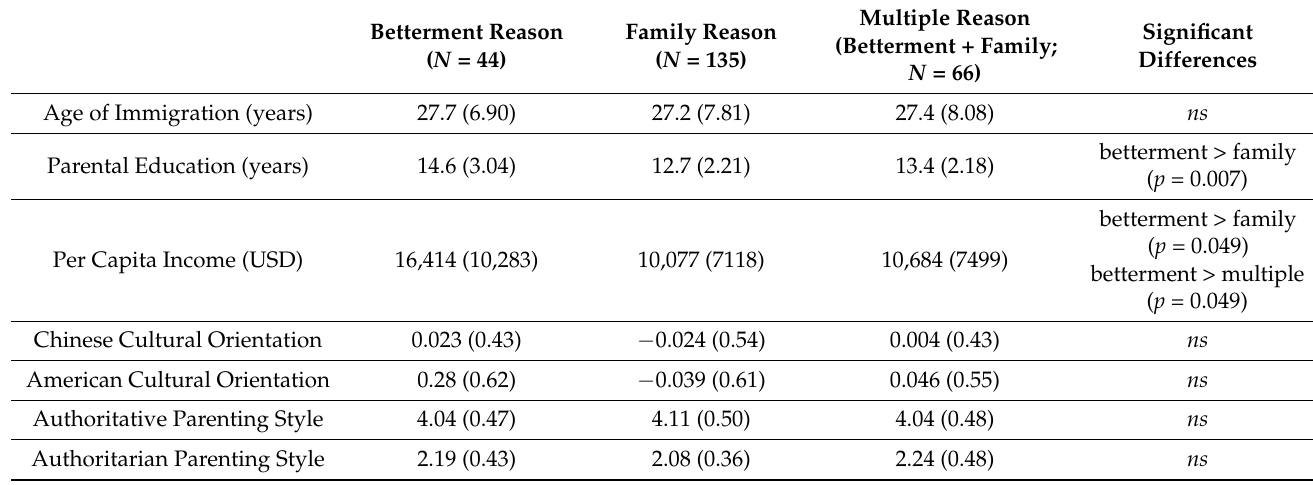
Table 2. Descriptive Statistics of Study Variables by Reasons for